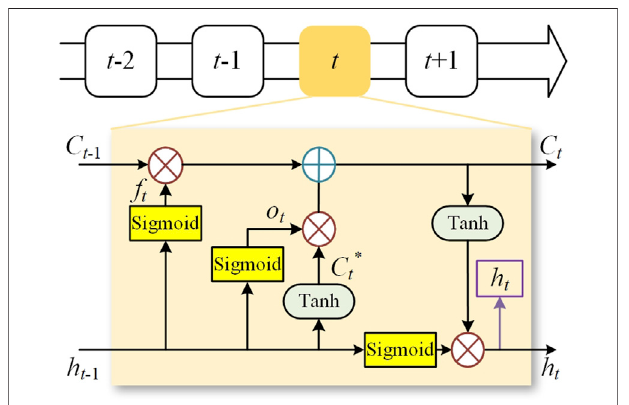
FIGURE 4 | Process of the LSTM model.